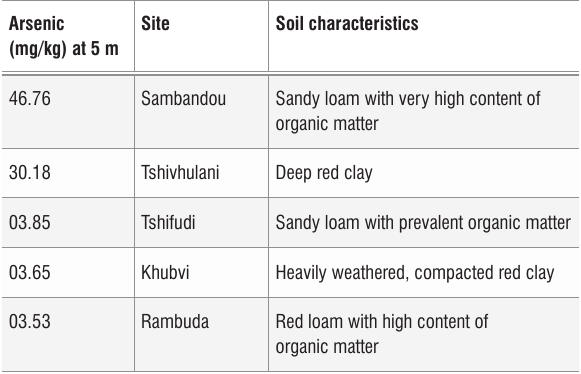
Table 3: Arsenic concentrations at 5 m from the dip tank and sur- rounding soil characteristics Arsenic (mg/kg) at 5 m